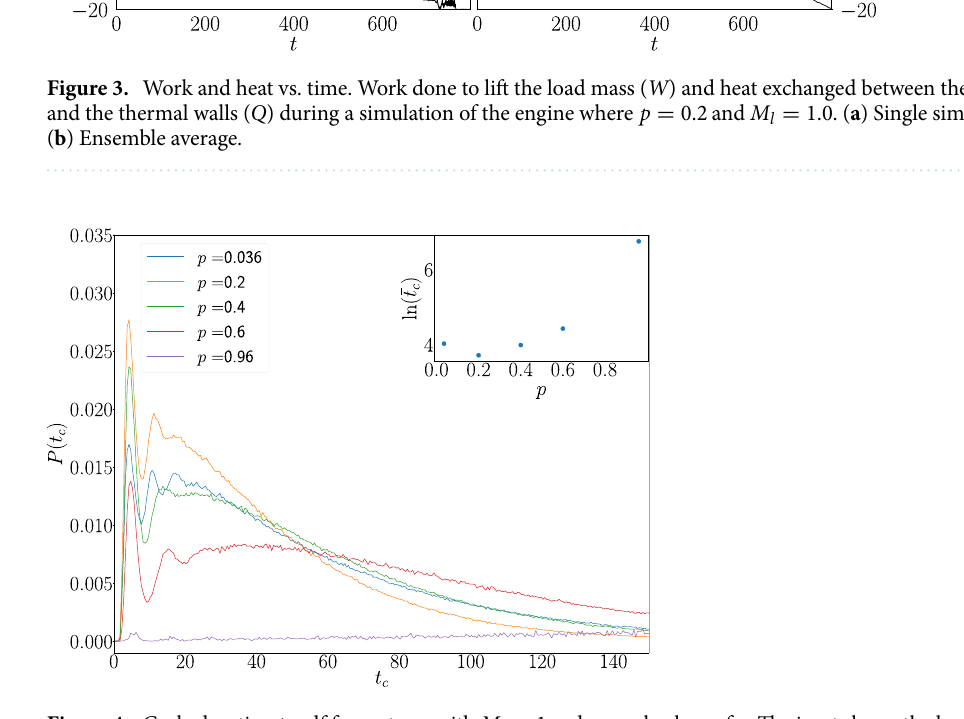
Figure 4. Cycle duration t c pdf for systems with M l = 1 and several values of p . The inset shows the logarithm of average cycle duration time ¯ t c as a function of p